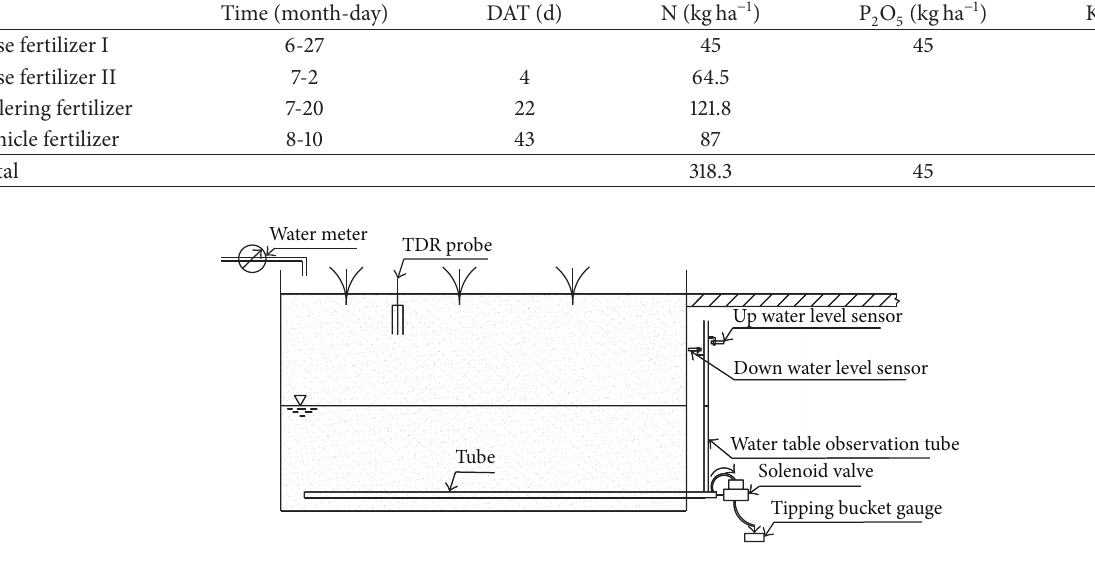
Figure 2: Automatic water table control